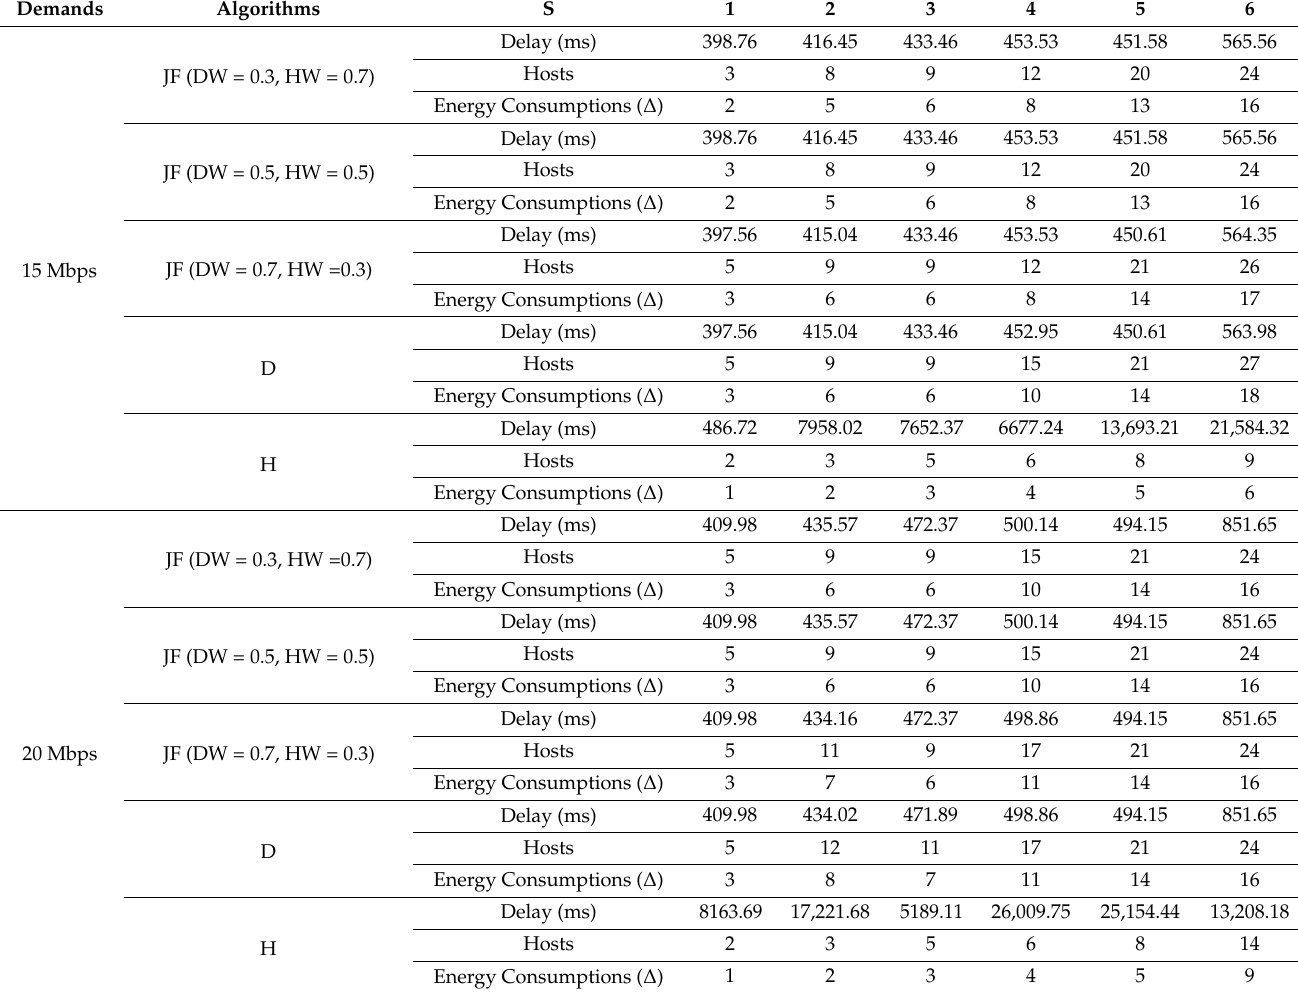
Table 6. Consequences of all three algorithms when demand = 15 Mbps, 20 Mbps for S = 1, 2, 3, 4, 5,